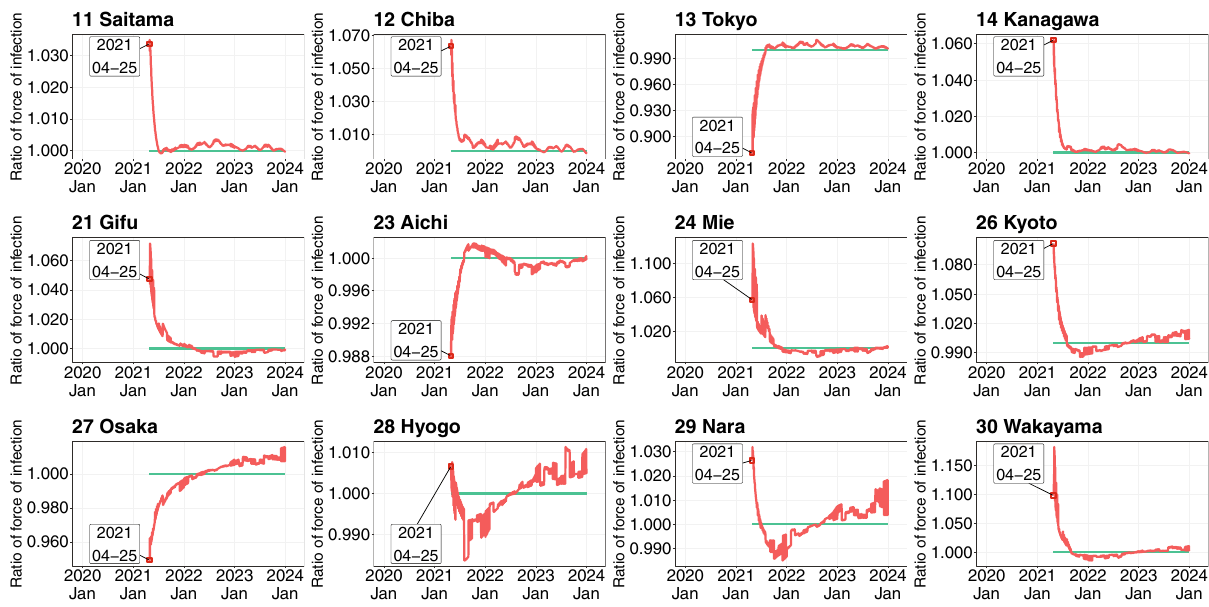
Figure 6. Ratio of daytime and nighttime force of infection by prefecture (see caption of Fig. 5 for